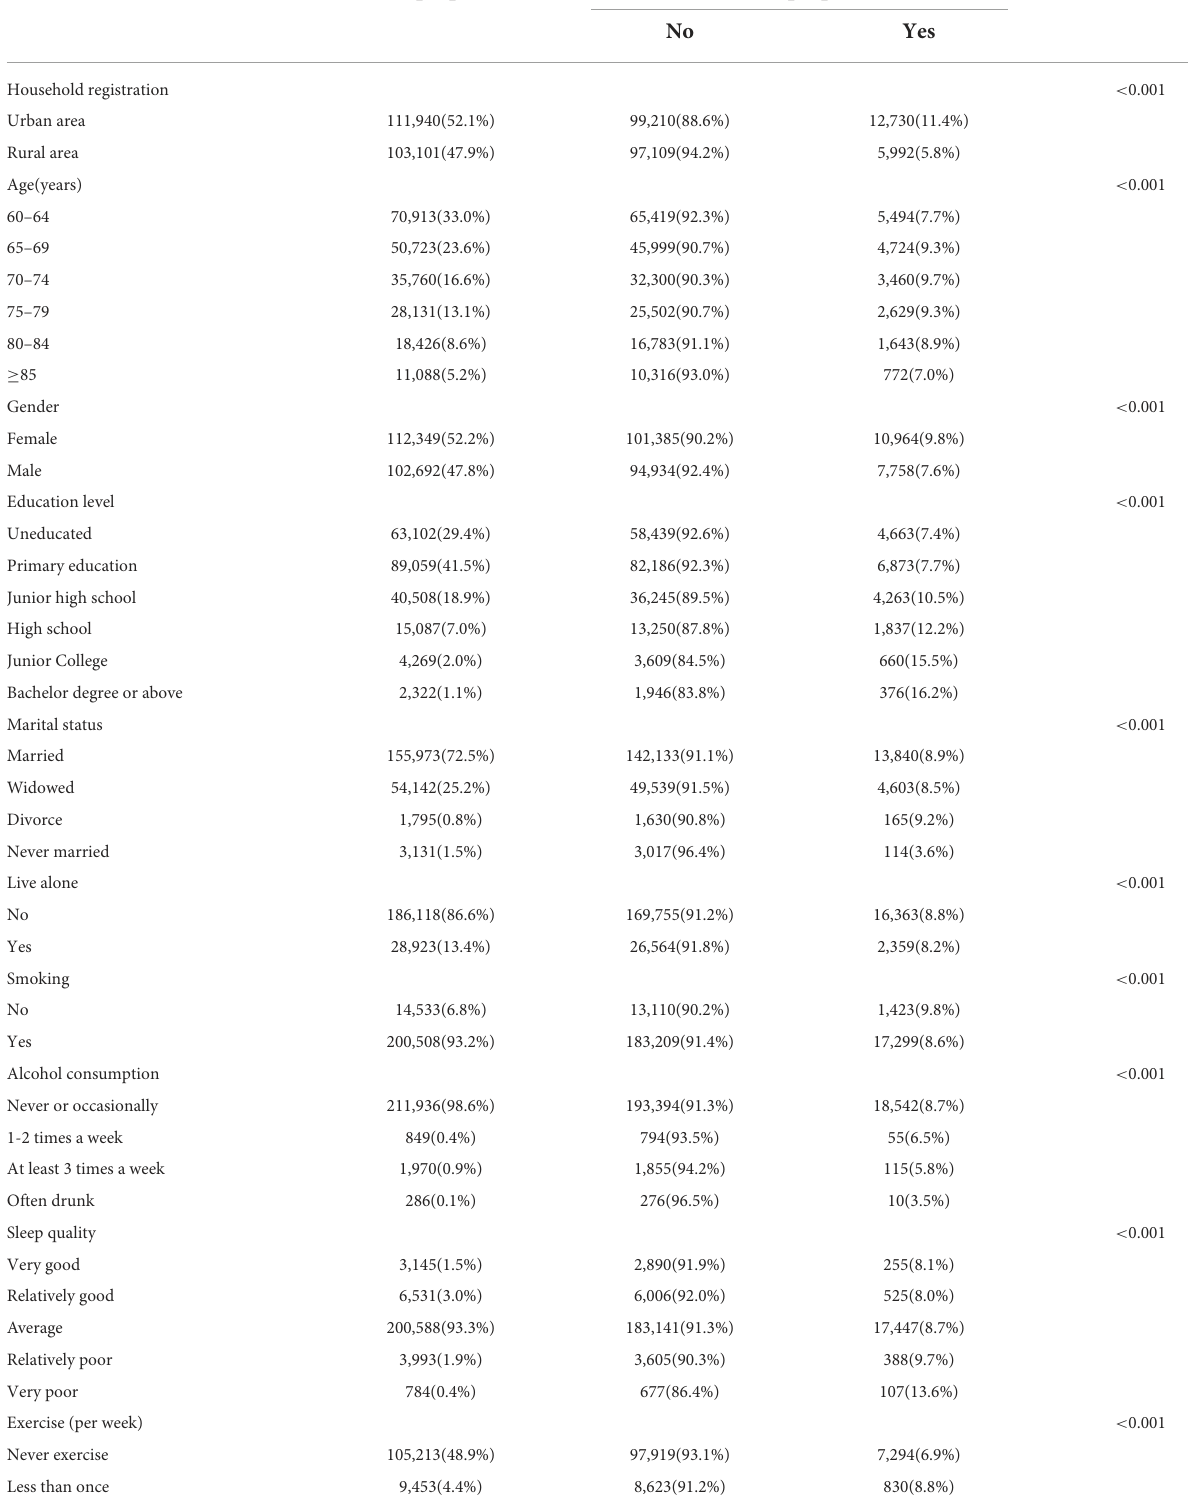
TABLE 2 The related factors of proportion with (or without) diagnosed